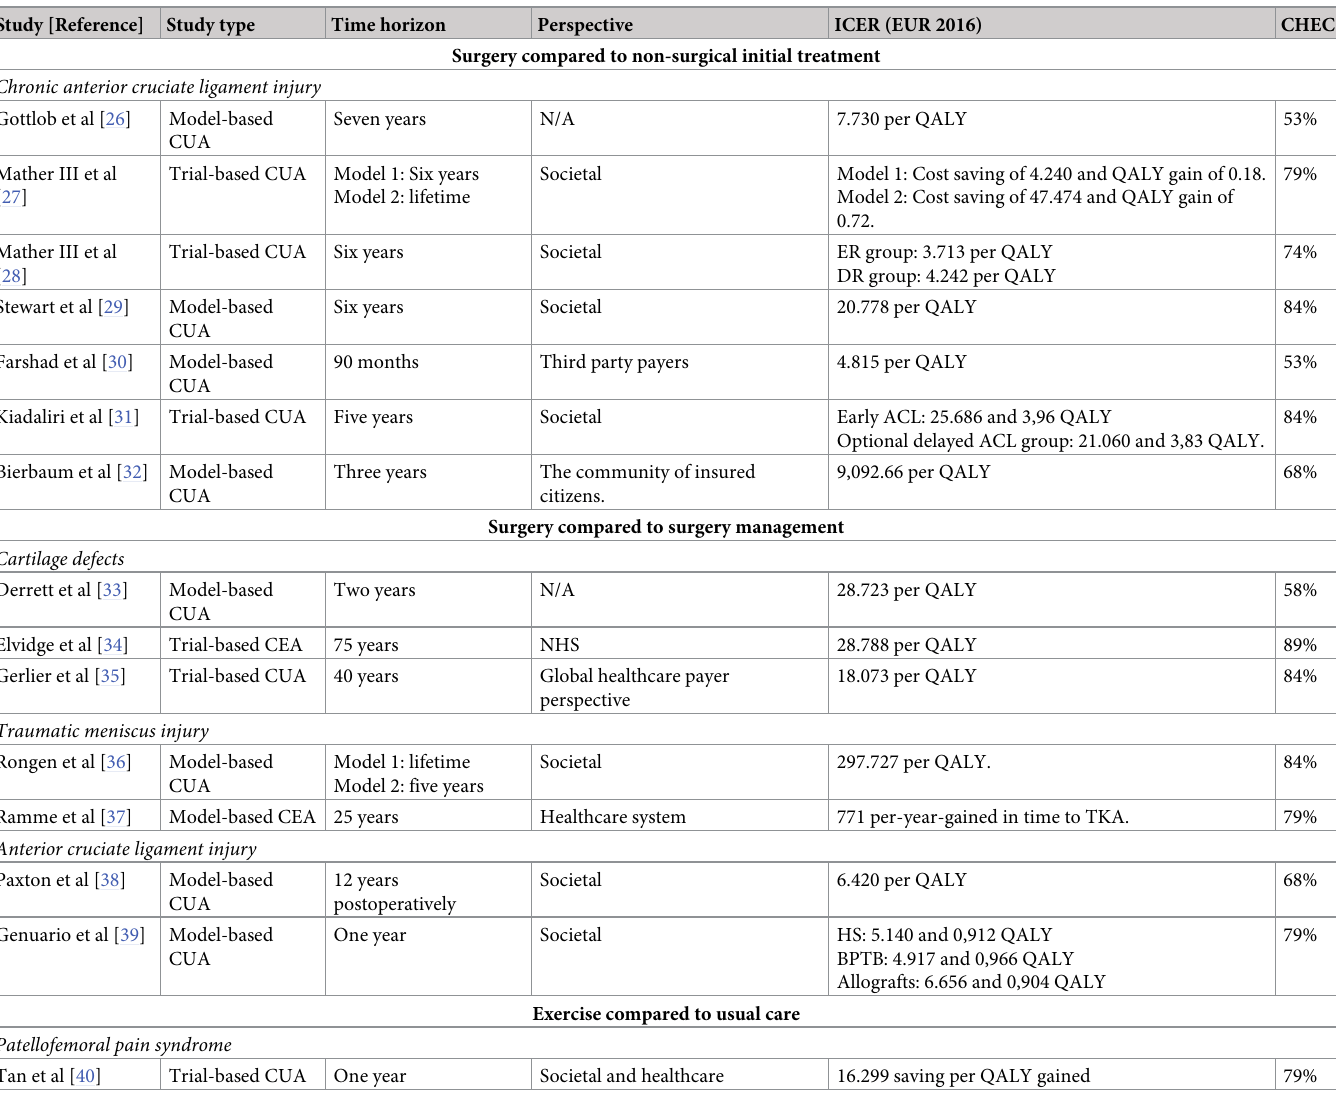
Table 3. Characteristics of the economic